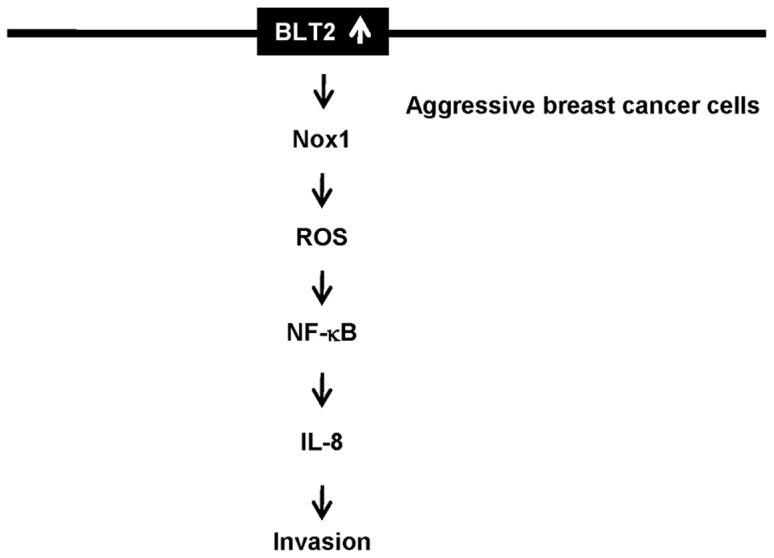
Scheme for the involvement of BLT2 cascade in IL-8 production and invasiveness of breast cancer cell.BLT2-induced IL-8 up-regulation leads to enhanced invasiveness of breast cancer cells. The activation of the BLT2 pathway induced Nox1-dependent ROS generation. Then, these ROS may contribute to NF-κB activation, which lead to IL-8-dependent invasiveness.